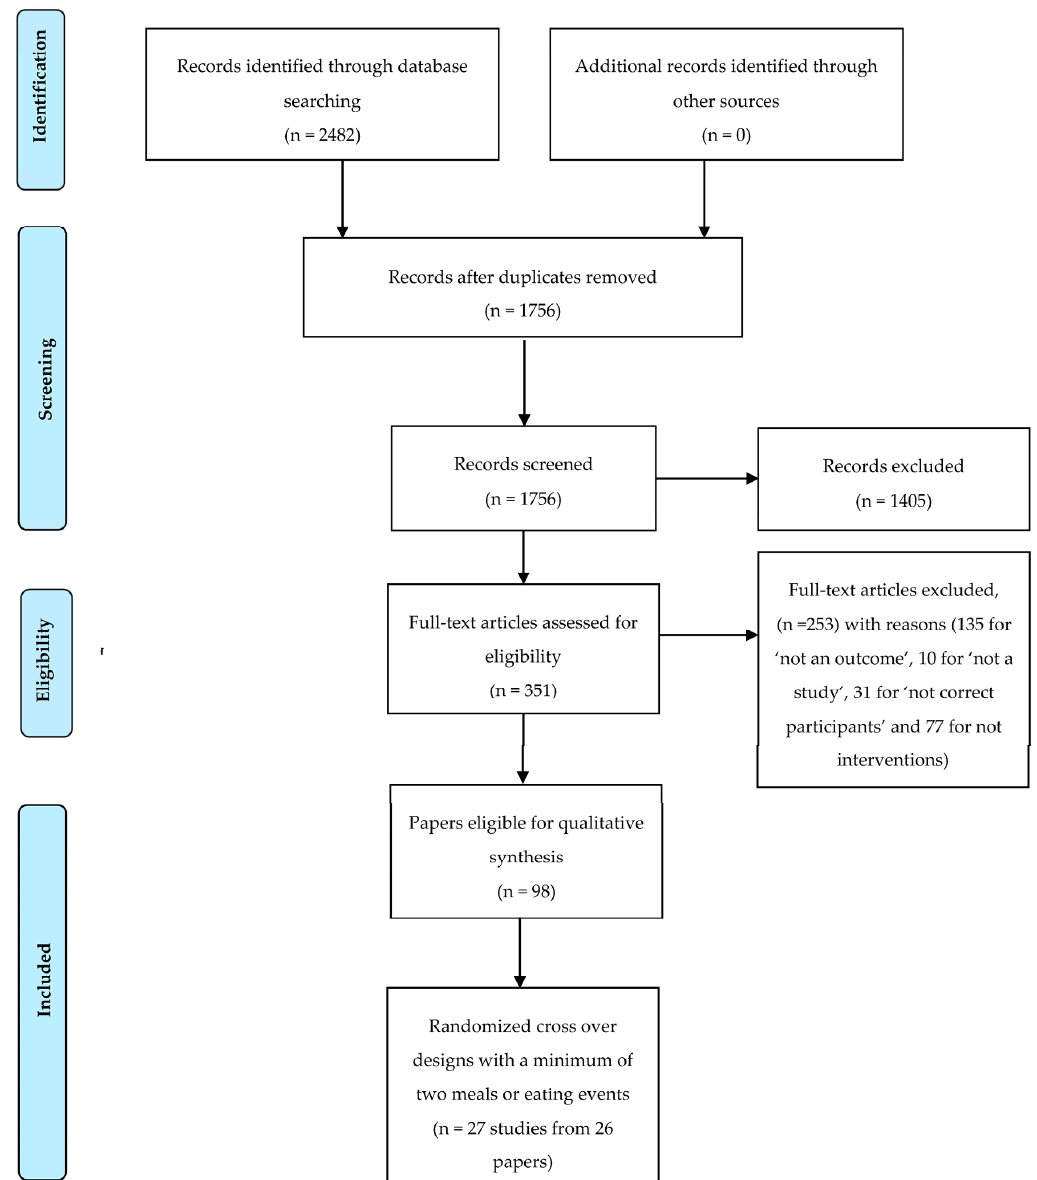
Figure 1. PRISMA Flow diagram [40] systematic search and review process.